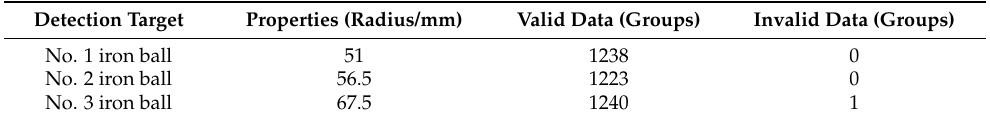
Table 3. Statistical table of measured data.